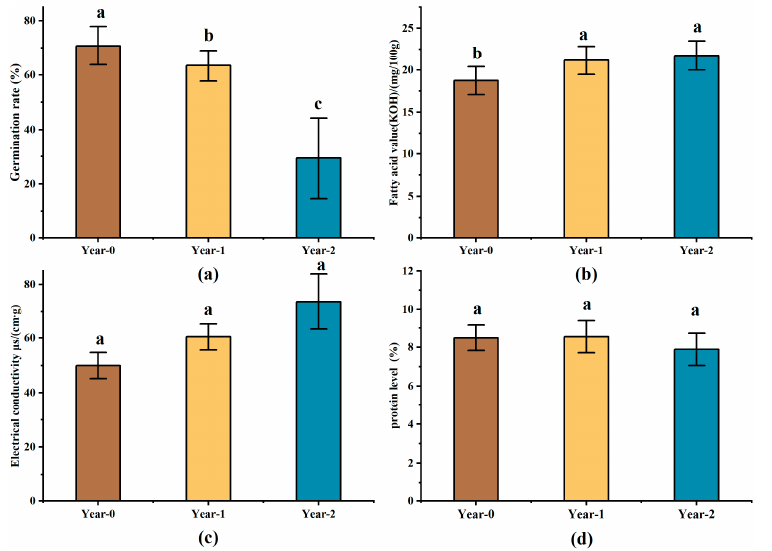
Figure 1. The changes in physical and chemical indexes of rice. ( a ) Germination rate, ( b ) fatty acid value, ( c ) electrical conductivity, ( d ) protein content. Different letters in this figure indicate there are significant differences among them. ( p < 0.05).